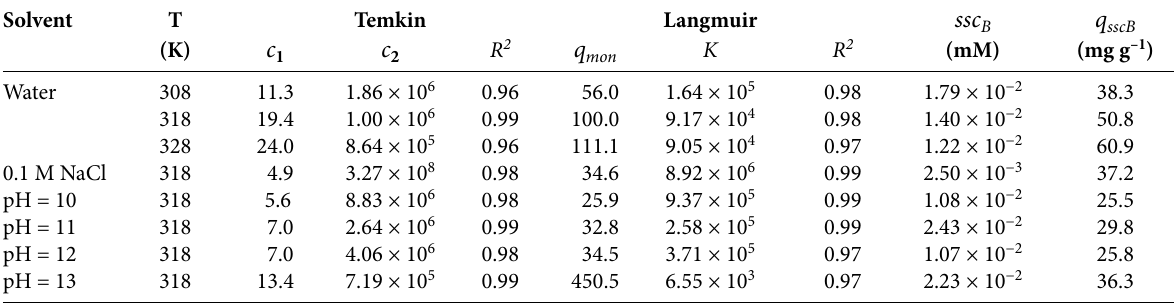
Table 2. Parameters obtained from the Temkin and Langmuir equations and ssc B and q sscB values for adsorption of CR on Mg-Al-LDH nano- compound in water, 0.1 M NaCl and alkaline solutions in section IIA (on MP site) at 308–328 K. Solvent T Temkin Water